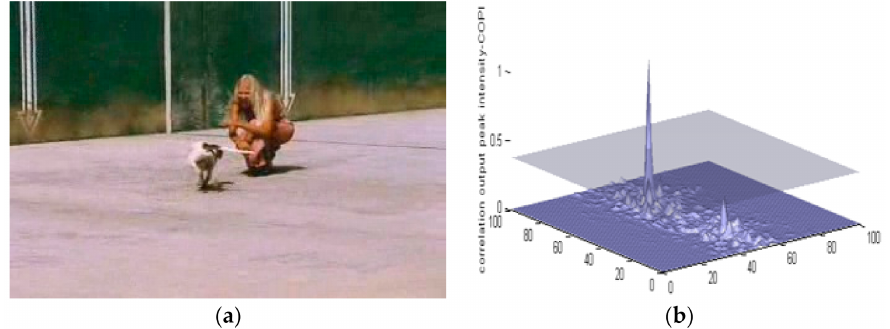
Figure 5. ( a ) A sample image of a Running Dog (Data Set-2) and ( b ) MACH results.